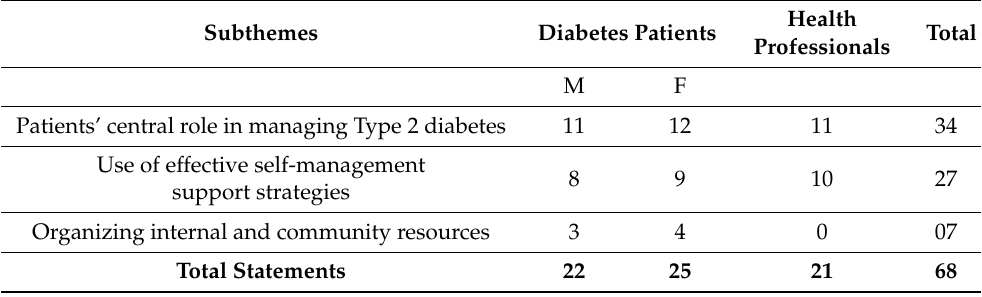
Table 2. Self-management of Type 2 diabetes outcome.